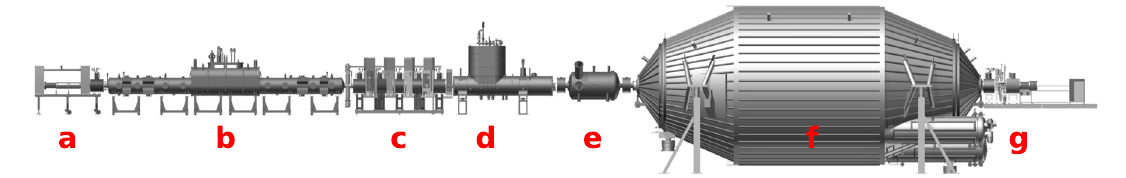
Fig. 1 The beamline of the KATRIN experiment. The electrons are created via tritium β -decay inside the WGTS ( b ). The rear section ( a ) contains calibration tools to determine the source parameters and for commissioning of the setup. The decay electrons are guided through the DPS ( c ) and CPS ( d ), where the tritium flow is reduced by 14 orders